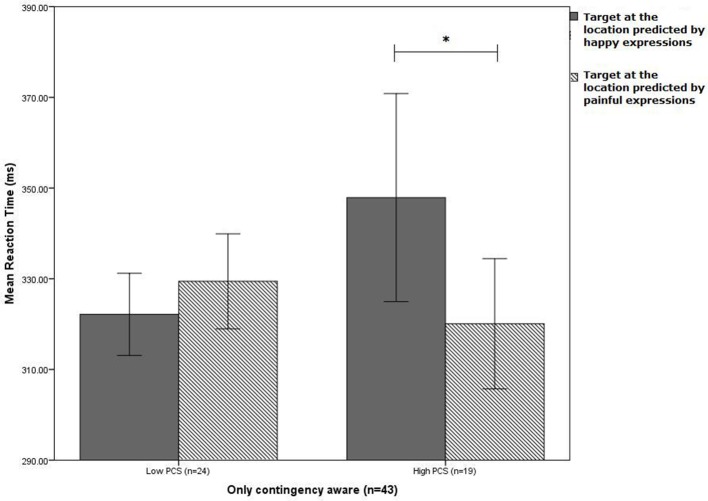
Mean reaction time of participants scoring relatively low and high on the Pain Catastrophizing Scale (PCS) to targets following morphed expressions at the location predicted by painful and happy expressions (*p < 0.05, there was no trend or other significant difference) (error bars represent s.e.m.).